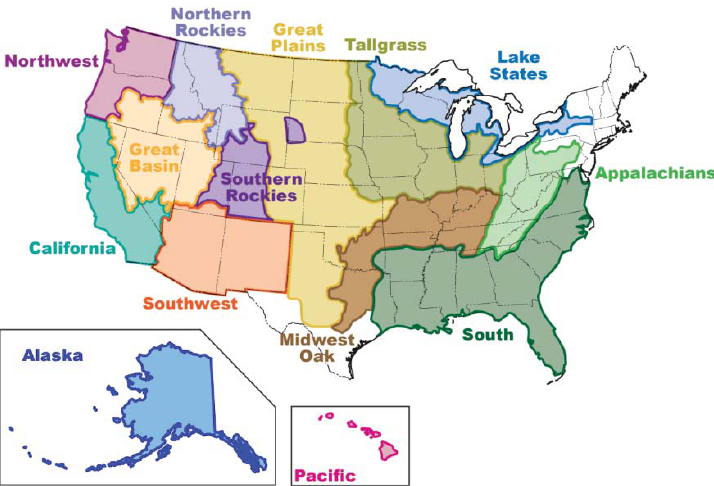
Figure 1. Map of the fourteen existing Regional Consortia funded by the Joint Fire Science Program [2]. The Lake States Fire Science Consortium covers the northern portions of Minnesota, Wisconsin and Michigan, and includes portions of Ohio, New York and the provinces of Manitoba and Ontario (not shown).